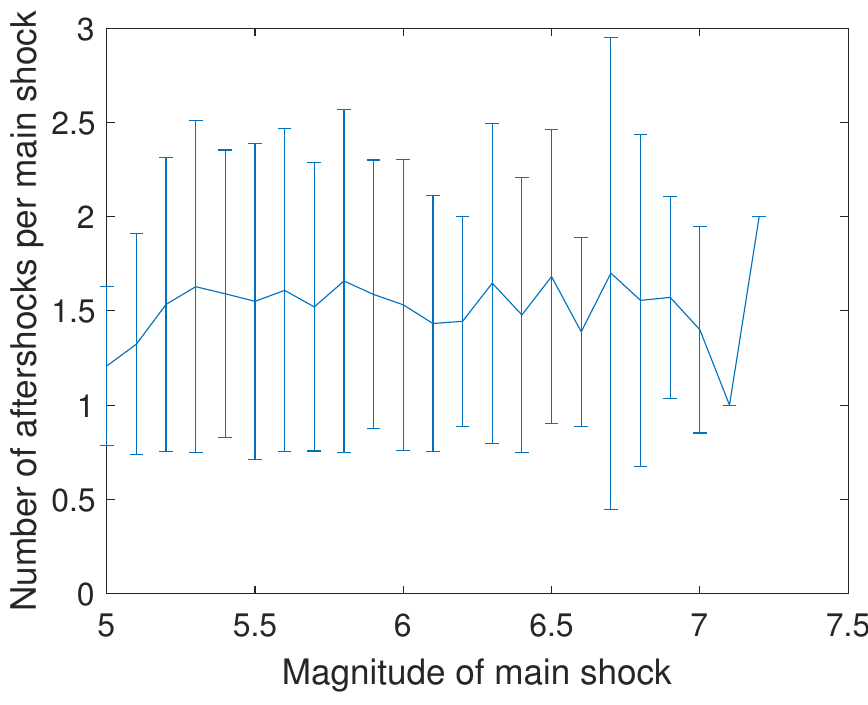
Figure 12. Number of aftershocks produced by one main shock according to magnitude of the latter. Error bars correspond to standard deviation observed in the 100,000-year synthetic